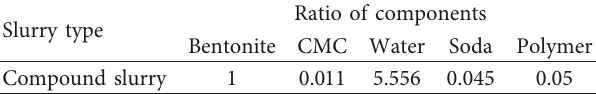
Table 3: Components’ ratio of thixotropic